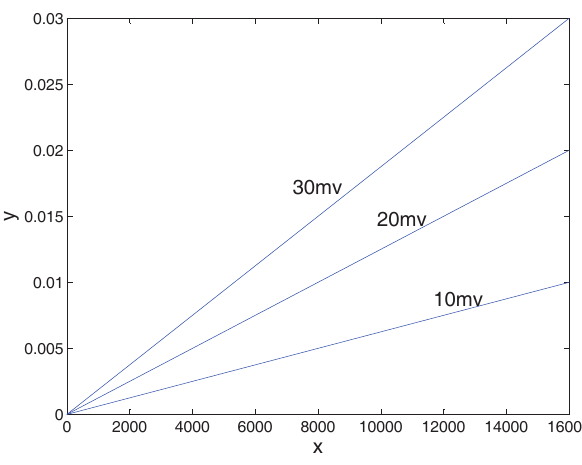
Figure 8. The error in different voltage fluctuations. The x -axis is the quantitative values of the sampling voltage. The y -axis is the sampling